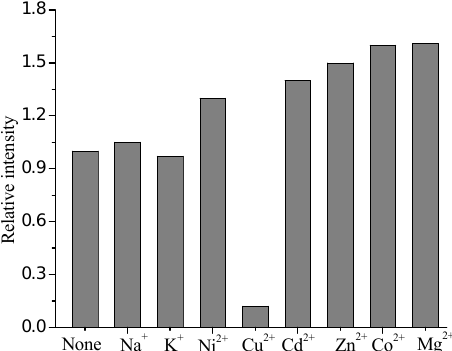
Figure 2. Relative fluorescence intensity at the metal ion to compound 2 mole ratio of 2.0 (almost the same even at 1.0) in the titration of 2 with different metal